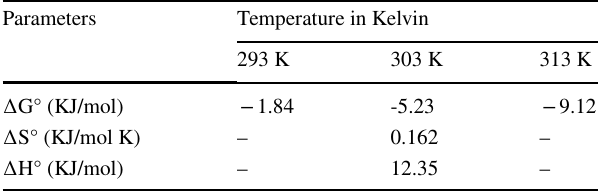
Table 3 Parameters from thermodynamics for MR sorption onto SCTJF Parameters